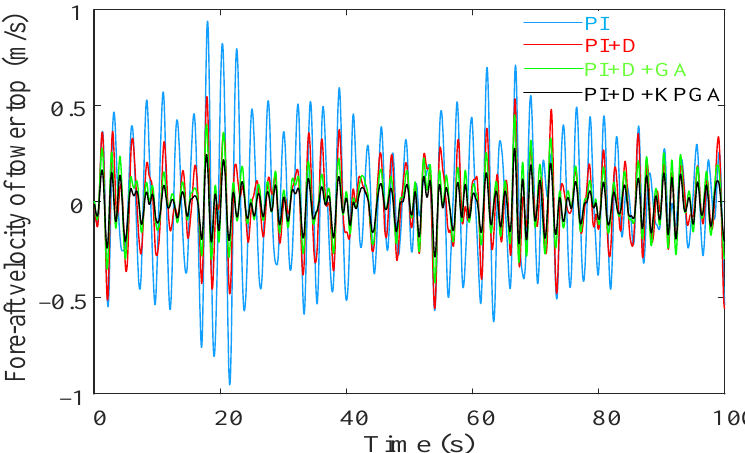
Figure 17. Change curve of fore-aft velocity for the tower top. Table 3. The tower fore-aft vibration indicators.